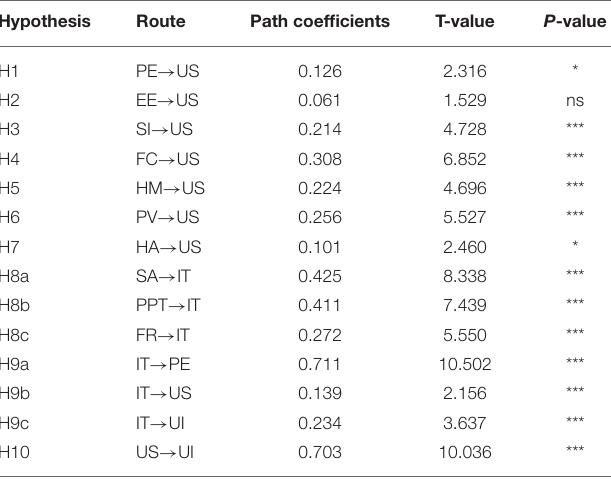
TABLE 5 | Results of hypotheses tests (Korea users’ samples). Hypothesis